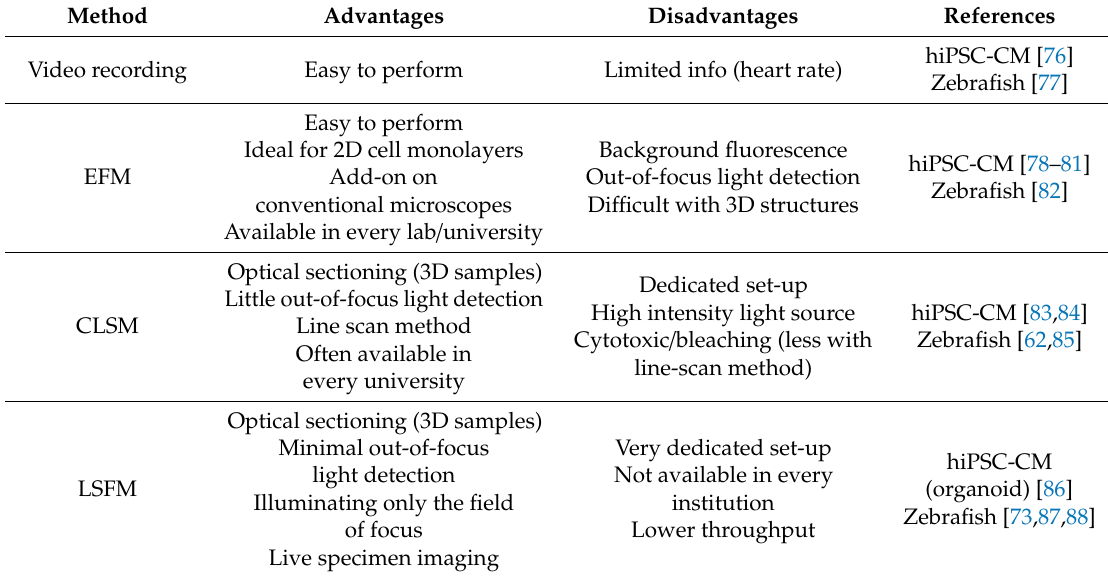
Table 1. Advantages and disadvantages of optical mapping techniques in human-induced pluripotent stem-cell-derived cardiomyocyte (hiPSC-CM) and zebrafish. Epifluorescence microscopy